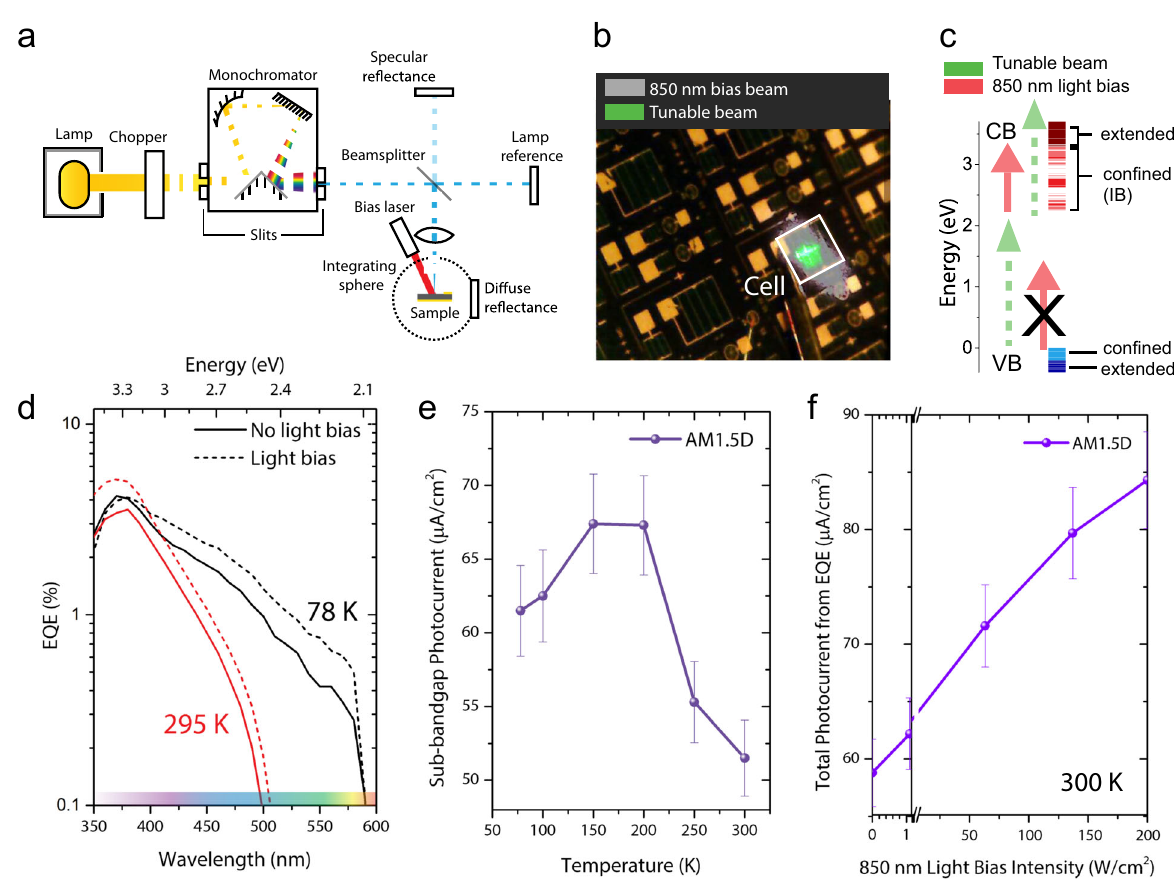
Fig. 3 Quantum ef fi ciency and photocurrent. a Schematic of the quantum ef fi ciency and re fl ectivity experimental setup including the laser light bias. b Microscope image of the solar cell with the tunable beam (green) and near-infrared light-bias beam (gray) spots. c Energy levels and transition energies showing the transitions enabled by the tunable beam and the 850 nm light bias. d Short-circuit quantum ef fi ciency at room temperature and 78 K with and without a 200 W/cm 2 light bias in a cryostat. e Sub-bandgap (>370nm) photocurrent as a function of temperature without light bias, calculated from quantum ef fi ciency measurements. Lines are guides to the eye. Error bars indicate estimated errors in photocurrent (±5%). f Calculated short-circuit current from the quantum ef fi ciency under AM1.5D illumination as a function of light-bias intensity at 295 K without a